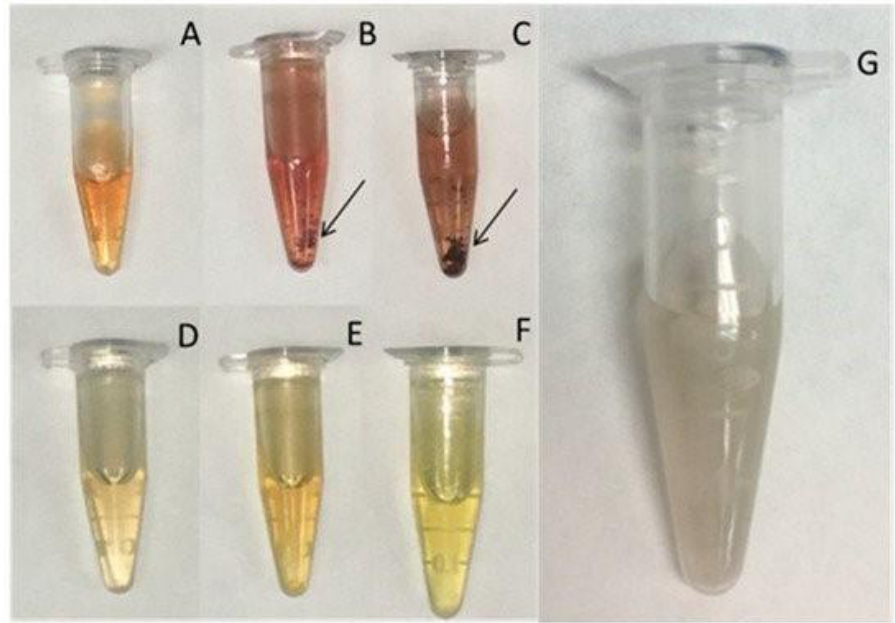
Figure 5. Visual evaluation of AgNP – polymer solutions after 5 h at 90 °C. ( A ) F1Q, ( B ) F2Q, ( C ) F3Q, ( D ) F1L, ( E ) F2L, ( F ) F3L, and ( G ) parent chitosan. Arrows indicate the presence of aggregates. ©